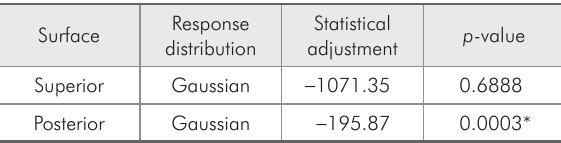
Table 4 - Analysis of variance results of the variables ana- lyzed to determine the effects of the protocols used.